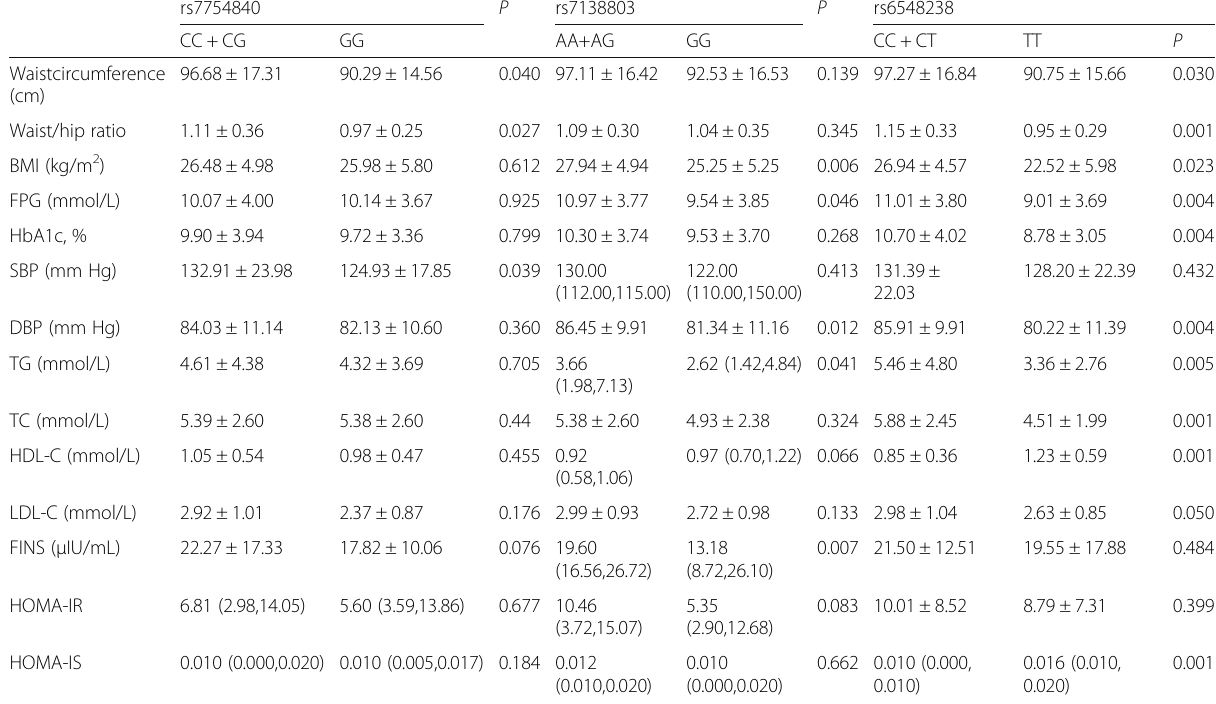
Table 5 Comparisons of clinical characteristics among genotypes rs7754840, rs7138803, and